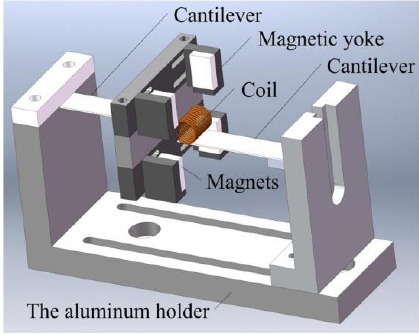
Figure 5. The design was proposed by [53], which uses a moving coil induced by 4 magnets. The design also has adjustable cantilevers for both the coil and magnets.